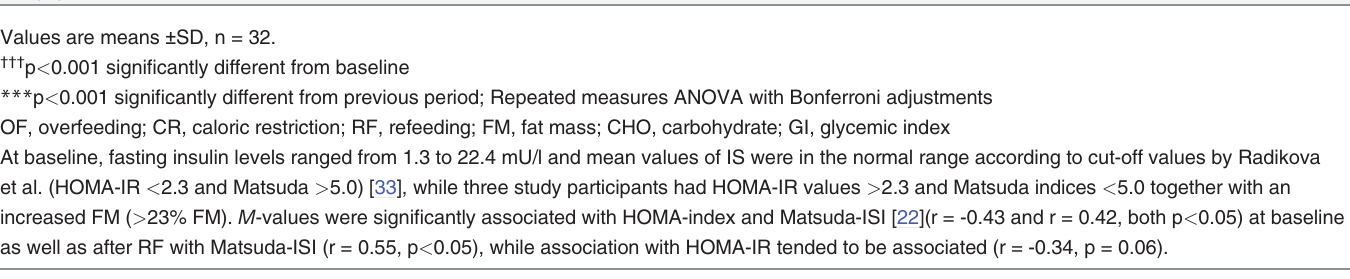
(Table 2). By contrast, no OF-induced changes in potential endocrine determinants were ob- served except for an increase in adiponectin (1.11 ±1.53 μ g/ml, p < 0.01) and a decrease in fT4 (-0.66 ±1.04 ng/l, p < 0.01) (Table 3). No associations were observed between changes in fasting